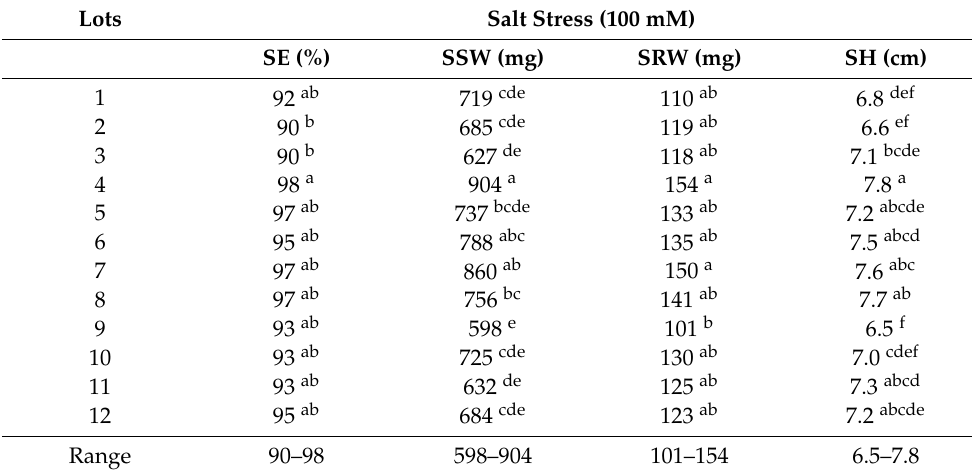
Table 3. Variation in seedling emergence (SE, %), seedling shoot weight (SSW, mg), seedling root weight (SRW, mg) and seedling height (SH, cm) at salt stress. Means with different letters are significant at the 5% level in each column.